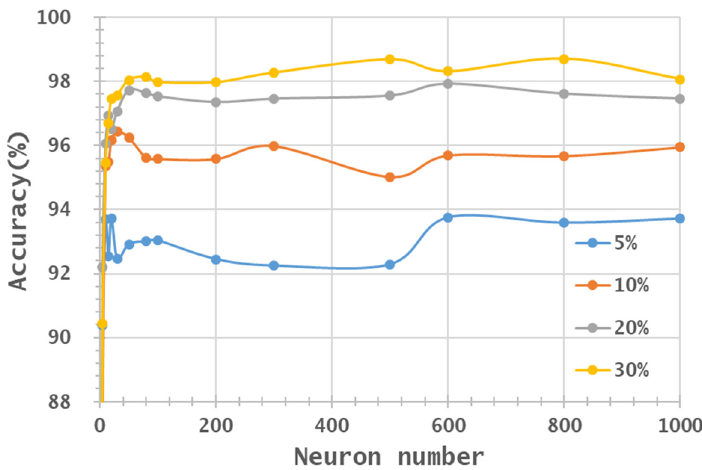
Figure 10. Accuracy distribution of PaviaU MNF1–14 + HHT image set, varying with training sample proportion and hidden layers.